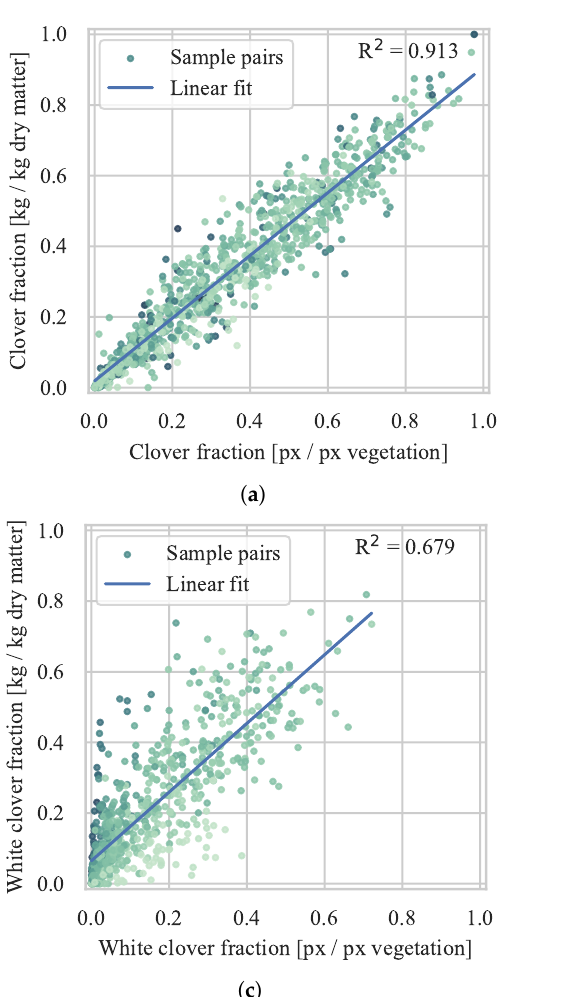
Figure 9. Visualization of the correlation between the predicted visual canopy fractions and the corresponding dry matter fractions. The top row represents 915 biomass samples. The second row represents a reduced set of 752 biomass samples, due to omitted clover species annotations in most biomass samples from plot trial site B. ( a – d ) represent clover, weeds, white clover, and red clover fractions,